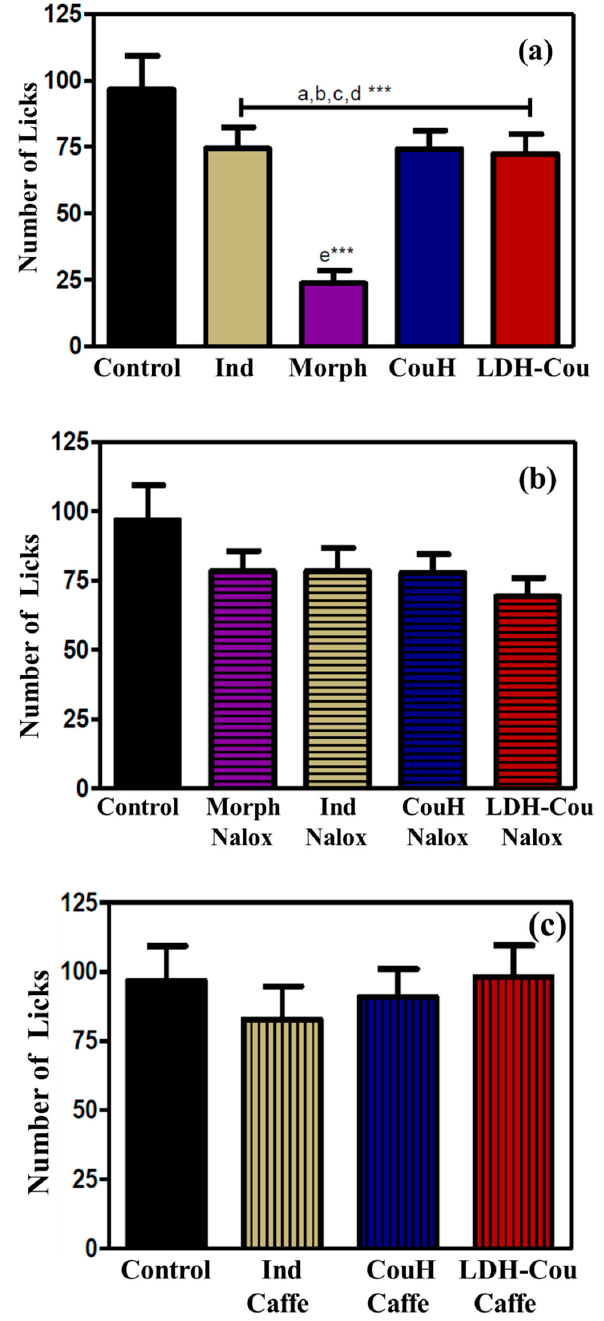
Figure 6. Formalin assay response from 0 to 5 min. ( a ) Groups without drug association; ( b ) Naloxone (Nalox) drug association; ( c ) caffeine (Caffe) drug association. Statistical analysis with significance set at *** p < 0.001 (ANOVA), where a—Ind vs. control; b—Morph vs. control; c—CouH vs. control; d—LDH-Cou vs. control; and e—Morph vs. Ind.